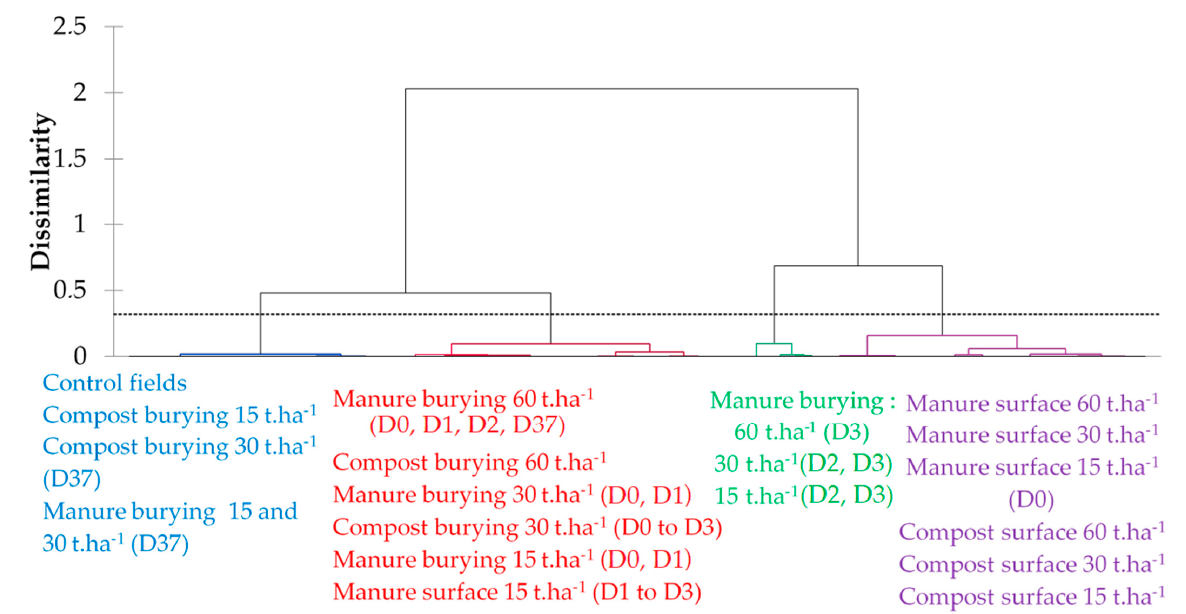
Figure 8. AHC dendrogram of the indices for all treatments, over time (day after EOM application indicated in brackets, or not if all days are in the same class). Classes 1, 2, 3, 4 in blue, red, green, purple colors, respectively.